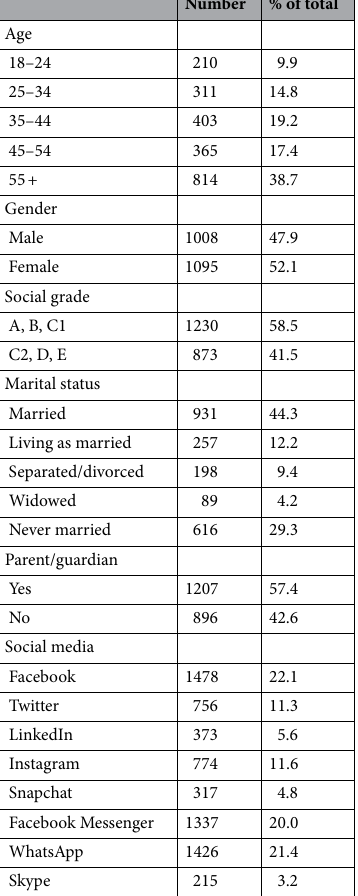
Table 1. Respondent key demographic variables. Note -respondents were able to respond with more than one choice of social media platform